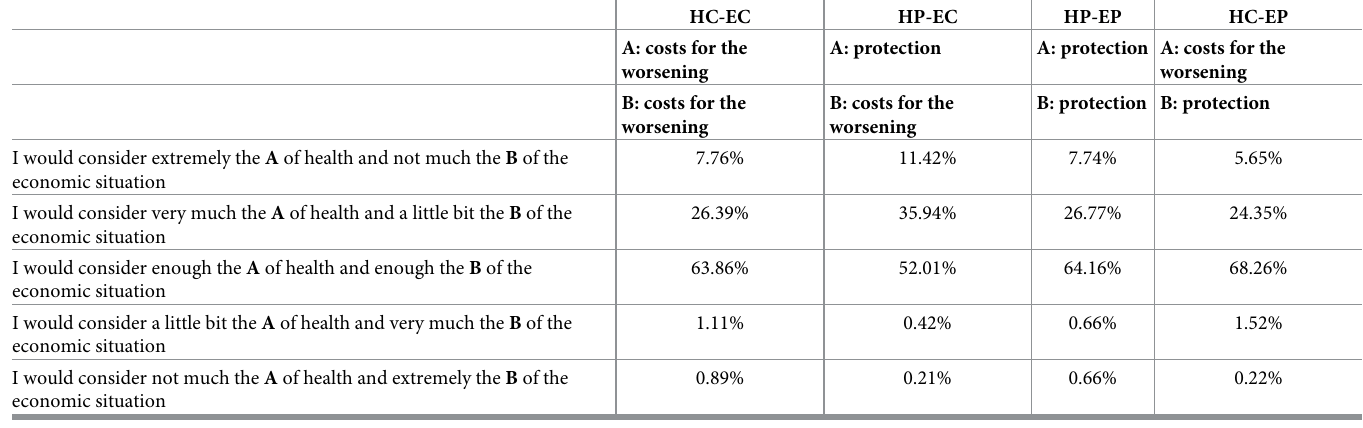
Table 1. Relative frequencies of responses by